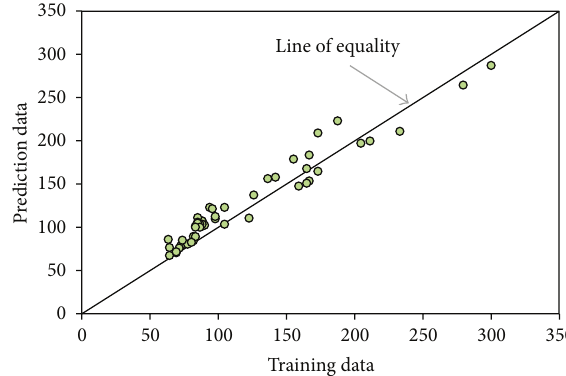
Figure 4: Comparison between training data and predicted data.